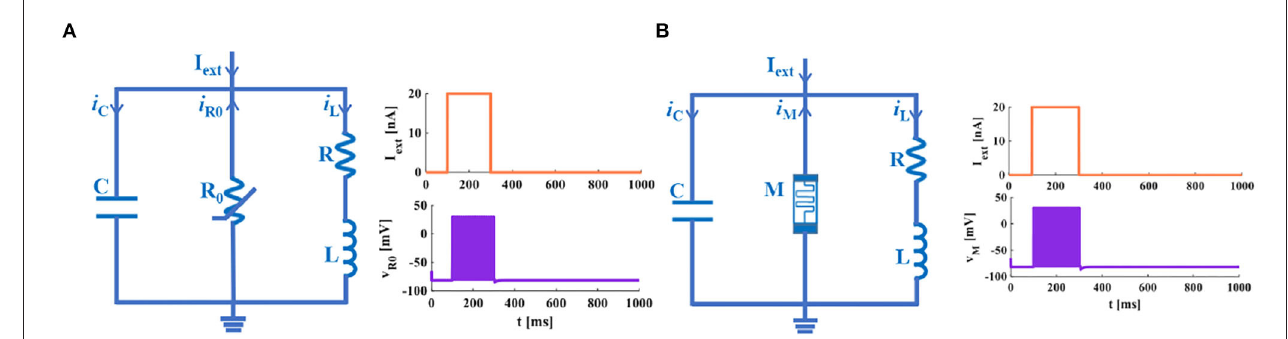
FIGURE 4 | The neuron membrane circuits. (A) The IZH circuit model and its response to a single pulse current. (B) The MIZH circuit model and its response to a single pulse